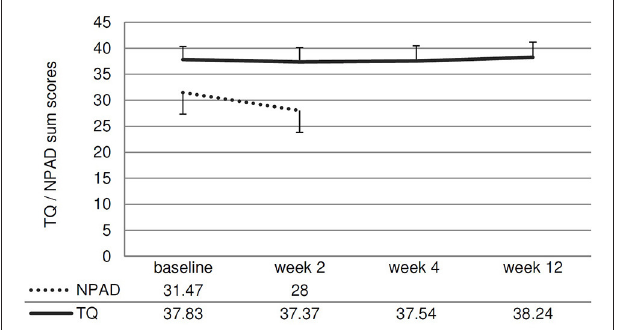
FIGURE 3 | Line chart showing the NPAD and TQ scores over time. Error bars represent standard errors. The change of the NPAD sum score is marginally